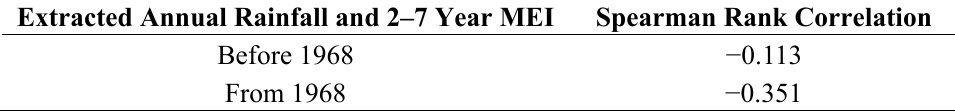
Table 5. Correlation results of rainfall-El Niño-Southern oscillation index (ENSO) relationship before and from